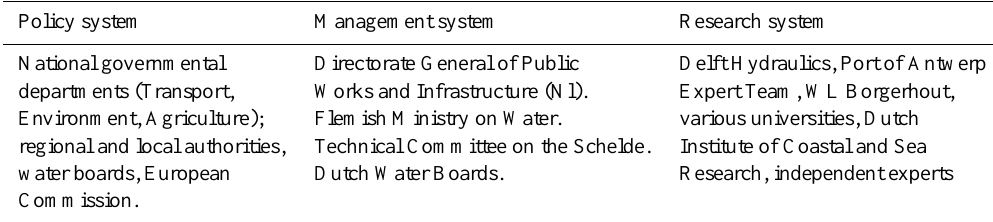
Table 1. Actor constellations around the Schelde.